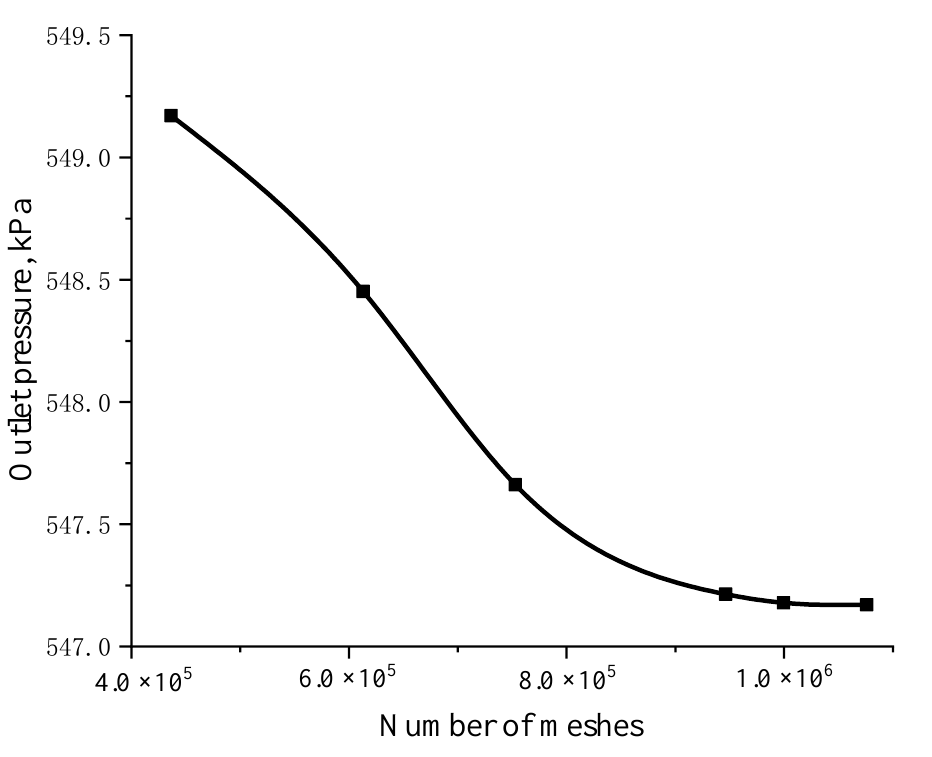
Figure 4. Mesh independence verification.